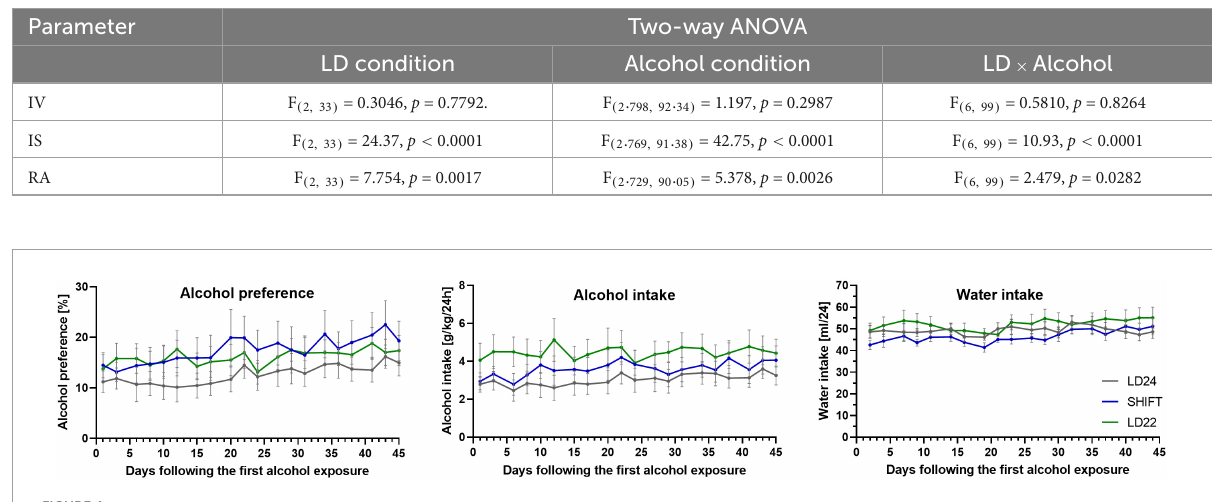
FIGURE4 Time course for alcohol and water consumption in rats exposed to LD24, SHIFT, and LD22 paradigms. ± SEM; n = 12/LD paradigm.